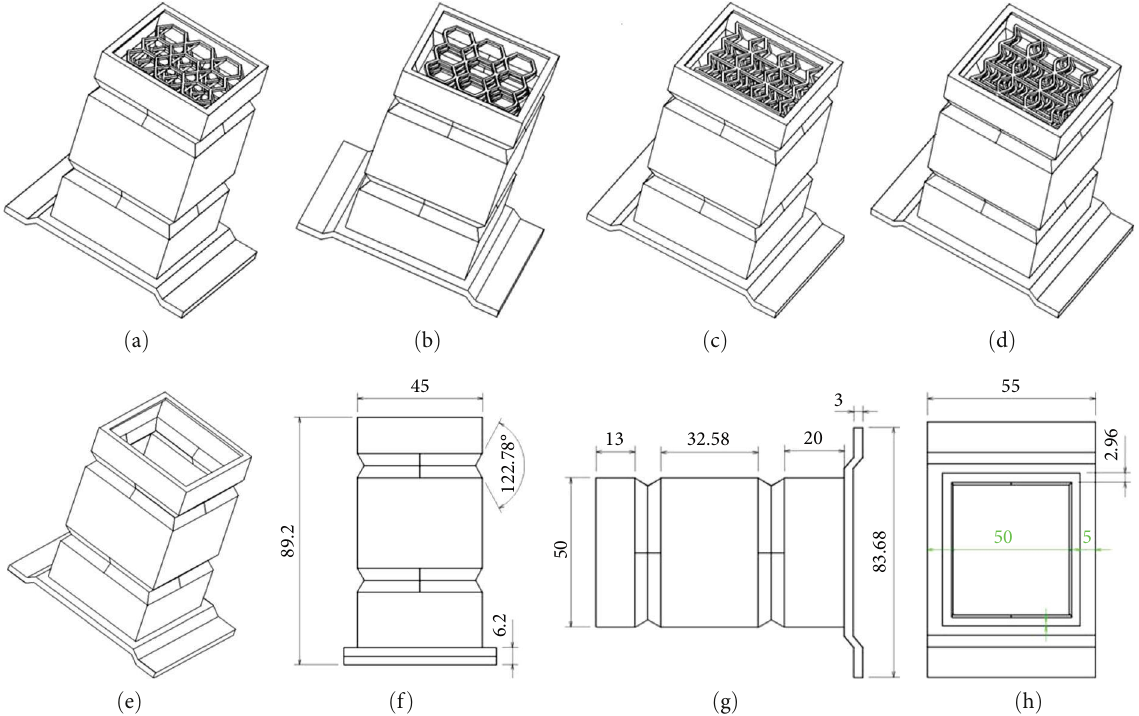
F IGURE 6: Bionic structure design of automotive energy absorbing box: (a) the HS automotive energy absorption box; (b) AHS automotive energy absorption box; (c) PS automotive energy absorption box; (d) APS automotive energy absorption box; (e) the automotive energy absorption box; (f) the right view of the automotive energy absorption box; (g) the front view of the automotive energy absorption box; (h) the vertical view of the automotive energy absorption box. In order to better compare the effect, steel is used in the simulation of bionic automobile energy absorption box